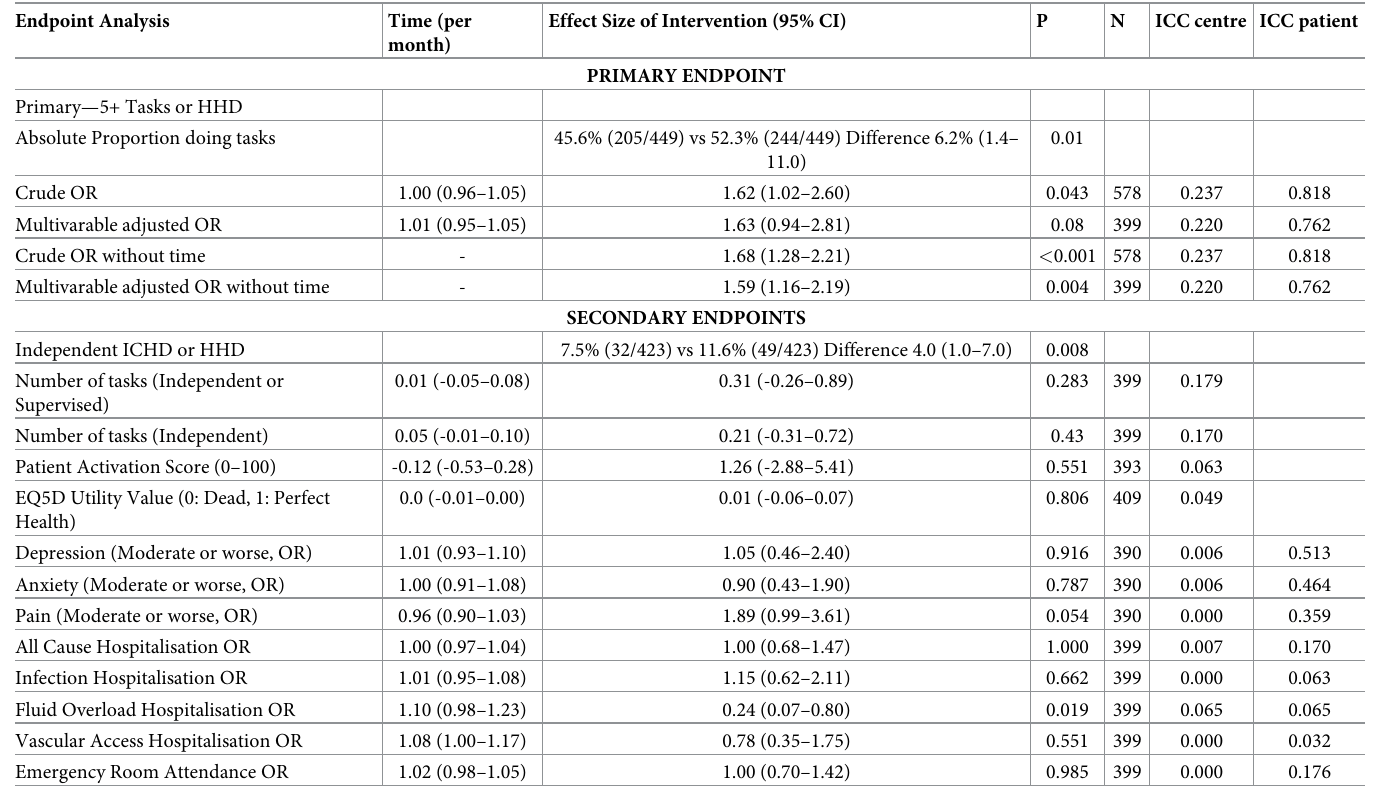
Table 3. Primary endpoint of five or more tasks or home hemodialysis, and secondary endpoints: Effect